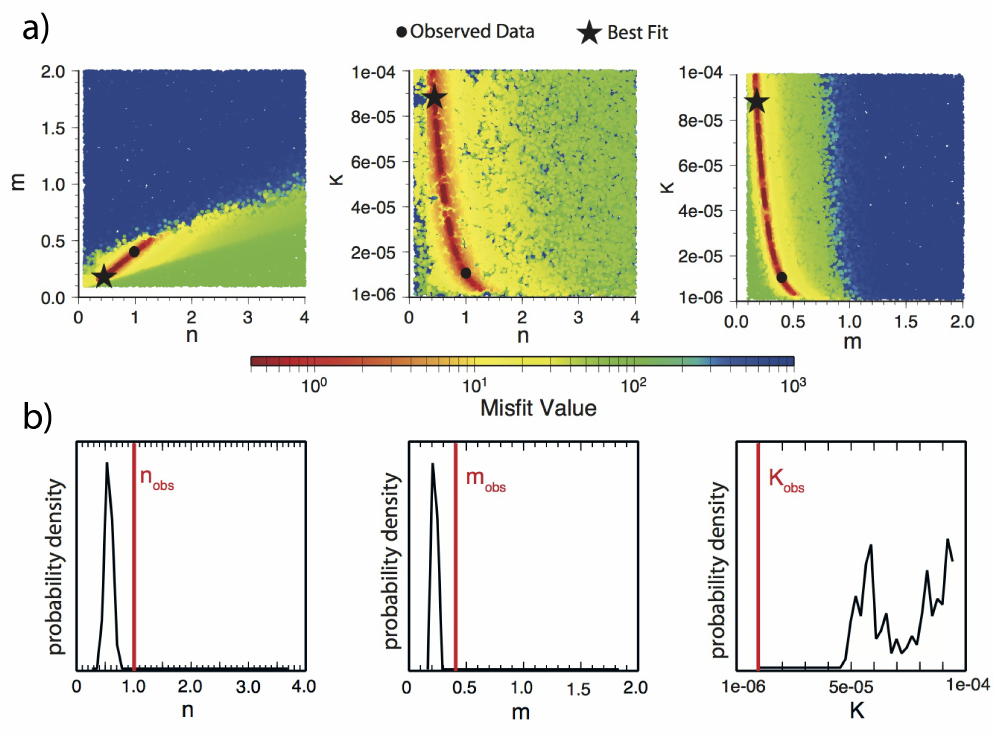
Figure 3. Results from inversion for the free parameters m , n and K . (a) Scatter plots showing the results from NA sampling stage. (b) PDFs of the three parameters resulting form the appraisal stage of